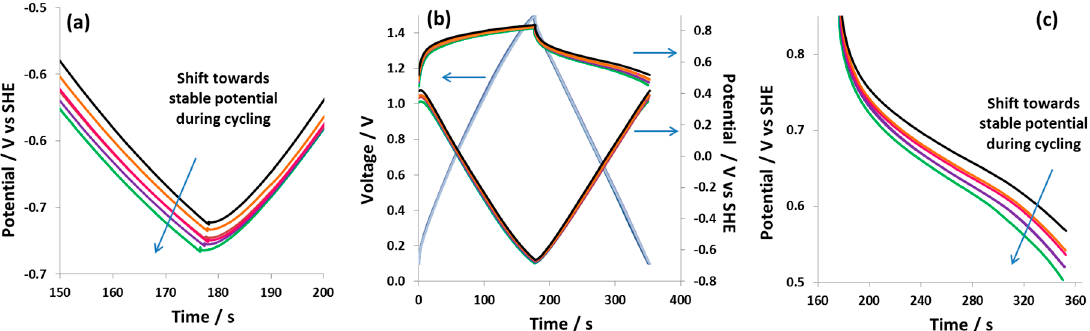
Figure 7. Galvanostatic charge / discharge curves (0.5 A g − 1 ) of hybrid cell 2 obtained in a two-electrode cell equipped with a reference electrode after every 1000th galvanostatic charge / discharge cycle ( a ) negative EDL electrode, ( b ) full cell, and ( c ) positive battery-like electrode.